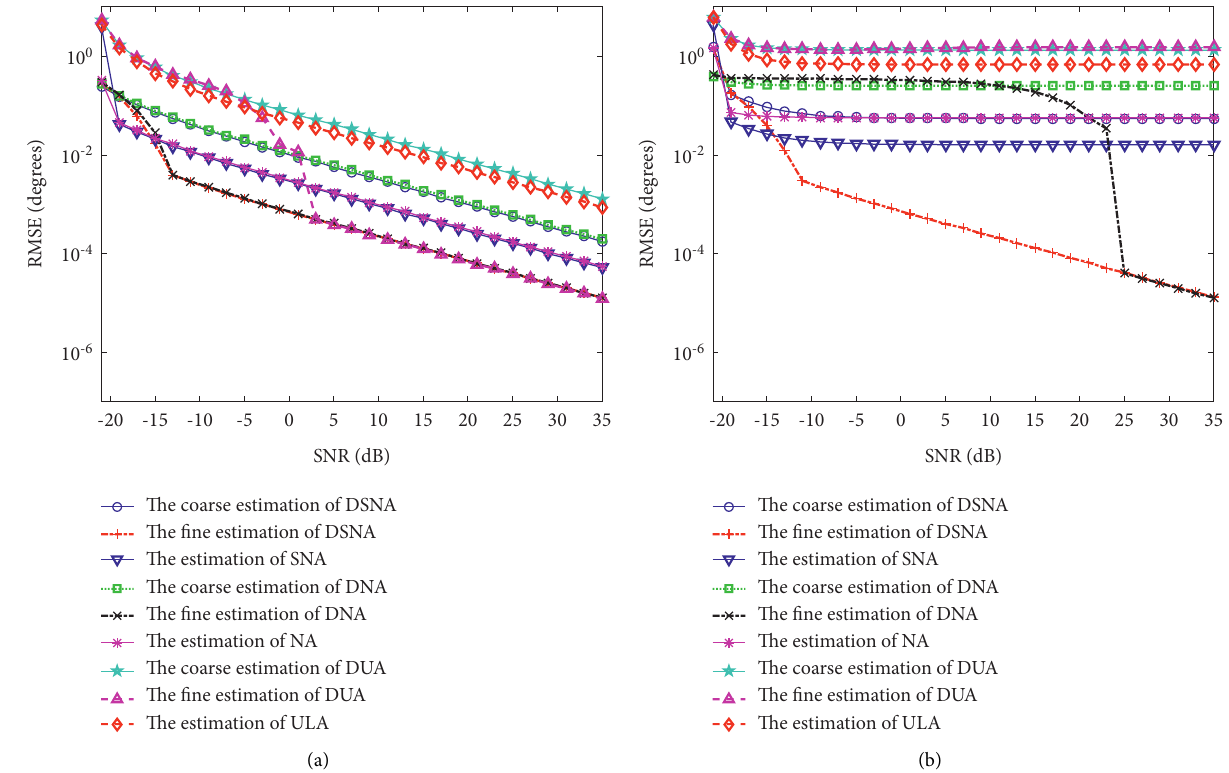
Figure 7: Single-source signal and d � λ /4; the baseline length is 130 times the wavelength. (a) Not considering mutual coupling between the array antennas. (b) Considering mutual coupling between the array